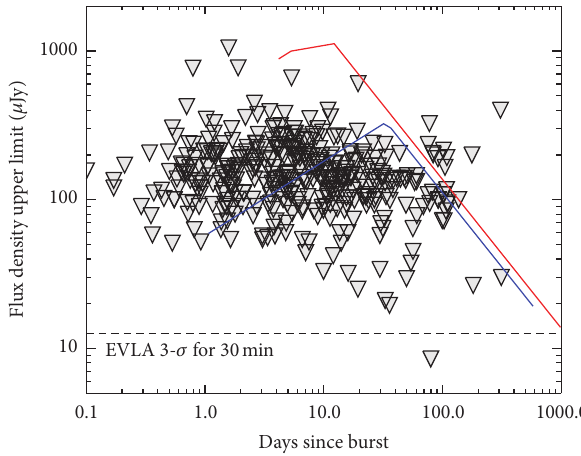
Figure 2: Plot of 3 - 𝜎 upper limits at 8.5 GHz frequency band for all GRBs for which no afterglow was detected. The red line shows light curve of a rare, bright event GRB 980703 and the blue line shows the light curve of a more typical event GRB 980329. The detection fraction of radio afterglows in the first 10 days certainly appears to be mainly limited by the sensitivity. The black dashed line indicates 3 - 𝜎 sensitivity of the JVLA in its full capacity for a 30-minute integration time. The figure is reproduced from